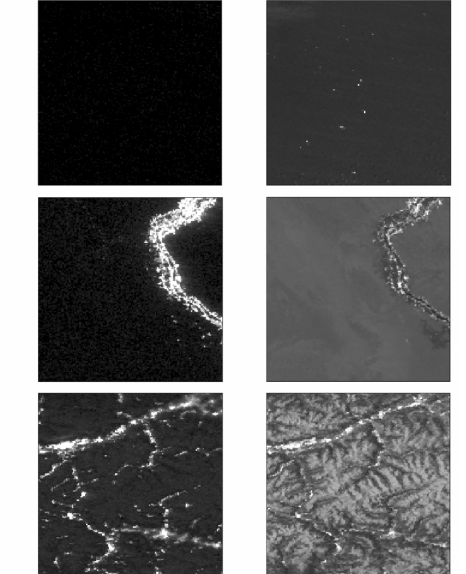
Figure 3. Cloud free ex. of Open Ocean (top left), Oil Platforms (top right), Desert (middle) & Snow (bottom); Moon-illumination-free (left) & Moon-illuminated (right)